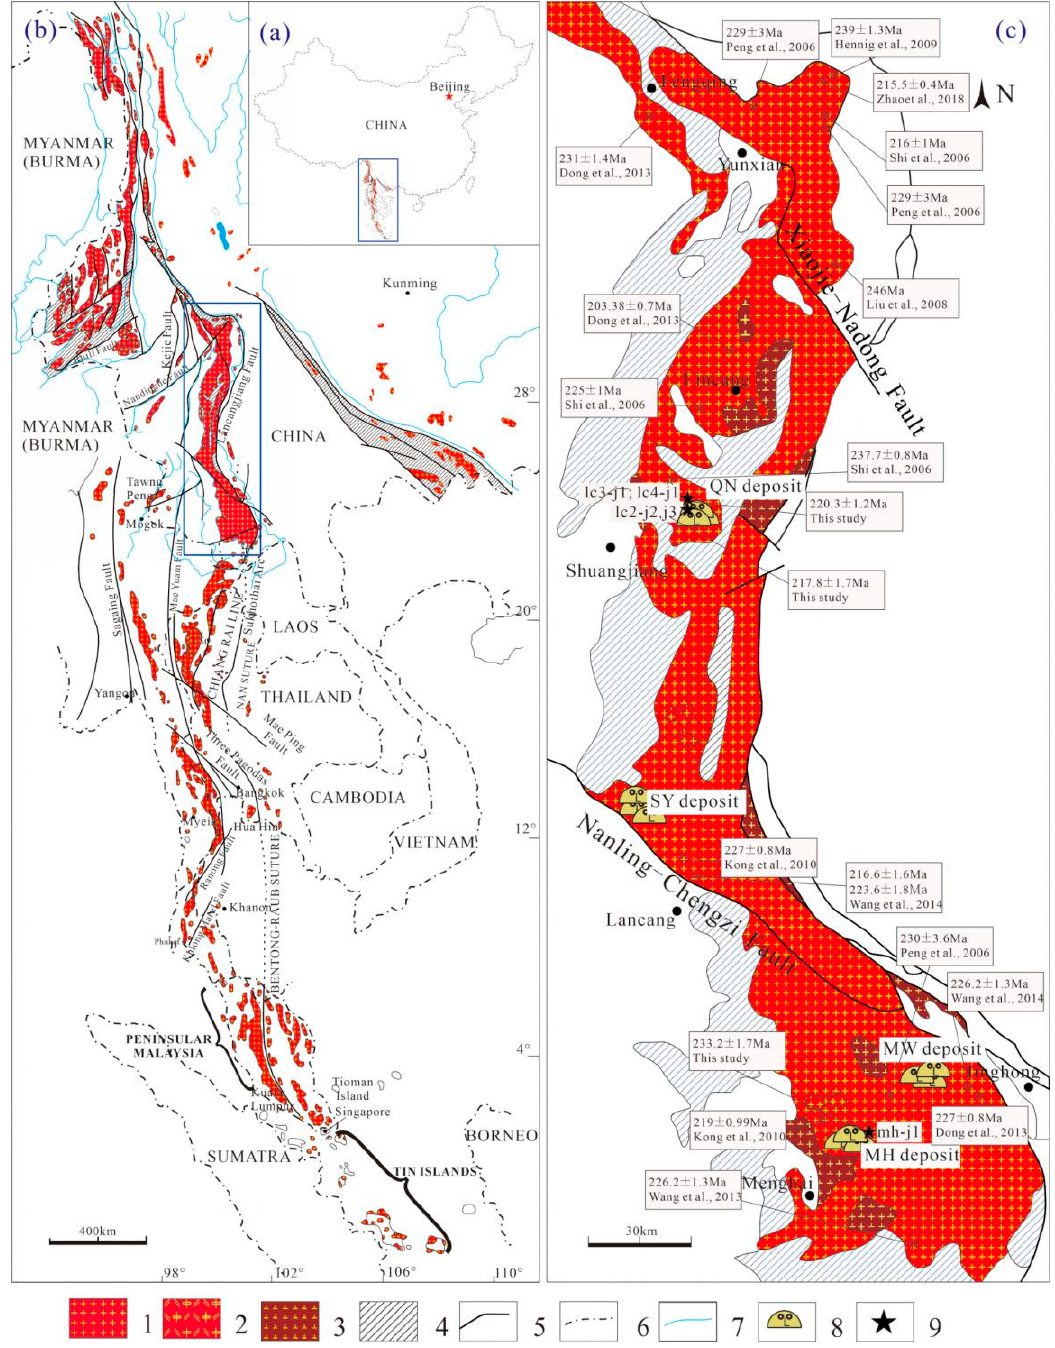
Fig.1 Regional geology of Lincang iRee deposits showing the location of the samples (after Cobbing et al., 1986 and Figure 1. The distribution of LC batholith in China ( a ) and Southeast Asia ( b ), and regional geology YNBGMR, 1990) of QN, SY, MW and MH iRee deposits showing the location of the samples ( c ) (modified from 1 － granite; 2 － porphyritic biotite monzogranite; 3 － granodiorite; 4 － metamorphic rock; 5 － fault; 6 － national boundaries; 7 － river; 8 － iRee deposit; 9-Sampled location references [33,36]). 1—granite; 2—porphyritic biotite granite; 3—granodiorite; 4—metamorphic rock; 5—fault; 6—national boundaries; 7—river; 8—iRee deposit; 9—Sampled